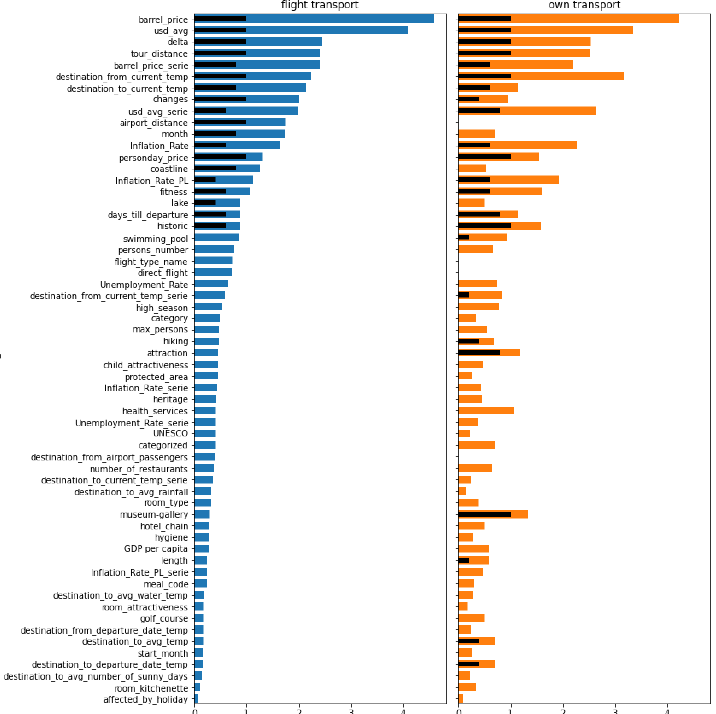
Figure 9. Final evaluation of features for n = 14. Blue and orange bars present the sum of the weights obtained by all five methods. Black bars indicate the result obtained using sequential backward elimination.